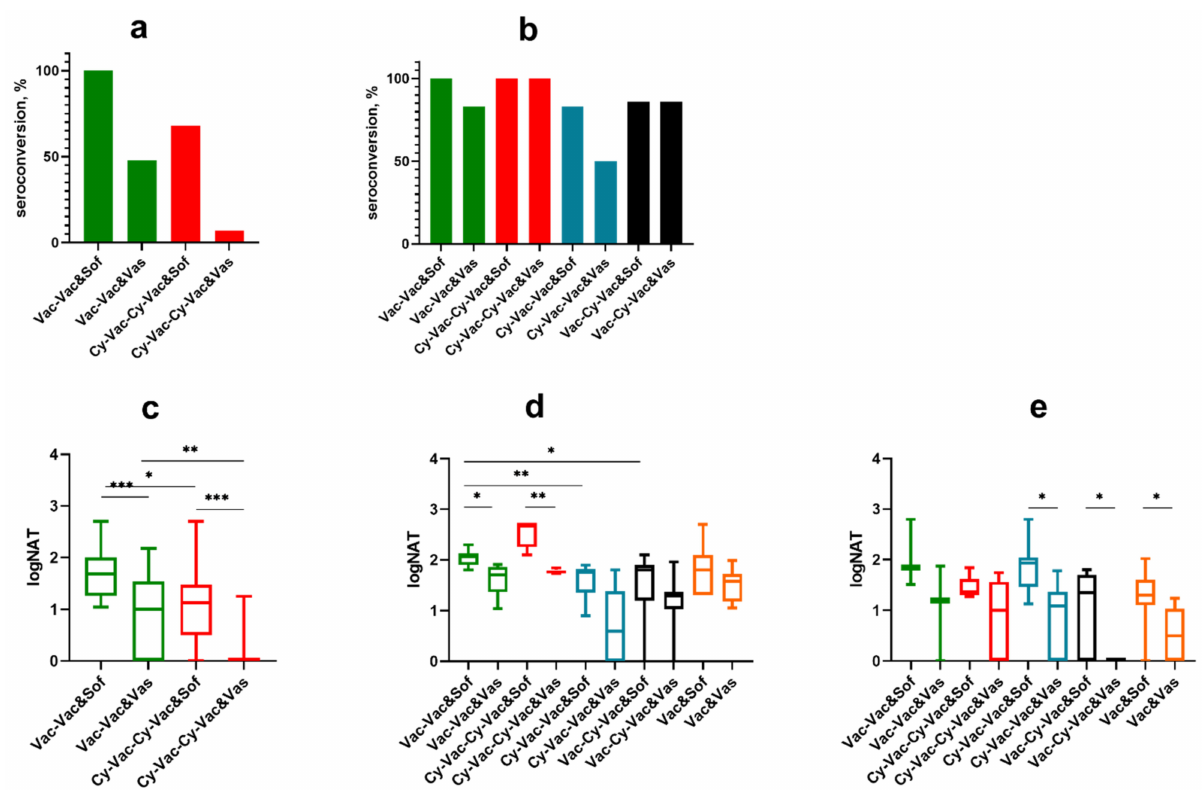
Figure 5. Seroconversion and levels of neutralizing antibodies against TBEV strains Sofjin (&Sof) and Vasilchenko (&Vas) in sera of Cy-treated mice (high-dose scheme). ( a ) Seroconversion rate after the first vaccine dose and ( b ) the second vaccine dose. Nab titer ( c ) after the first vaccine dose, ( d ) the second vaccine dose, and ( e ) one day after the challenge with 100 LD 50 TBEV strain Vasilchenko: Vac-Vac group was used as a control without Cy treatment (green); Cy-Vac-Vac received Cy treatment before the first vaccine dose (blue); Cy-Vac-Cy-Vac was treated with Cy twice: before the first and the second vaccine doses (red); Vac-Cy-Vac was treated with Cy before the second vaccine dose (black); and Vac was vaccinated only once (orange). In (a) and (c) Vac-Vac group includes the data for Vac-Vac, Vac-Cy-Vac and Vac groups, Cy-Vac-Cy-Vac includes the data for Cy-Vac-Vac group since at this stage of the experiment they received identical treatment. N = 7–8 animals per group. * p < 0.05; ** p < 0.01; *** p < 0.001 obtained by Mann-Whitney test. Box plots indicate median and